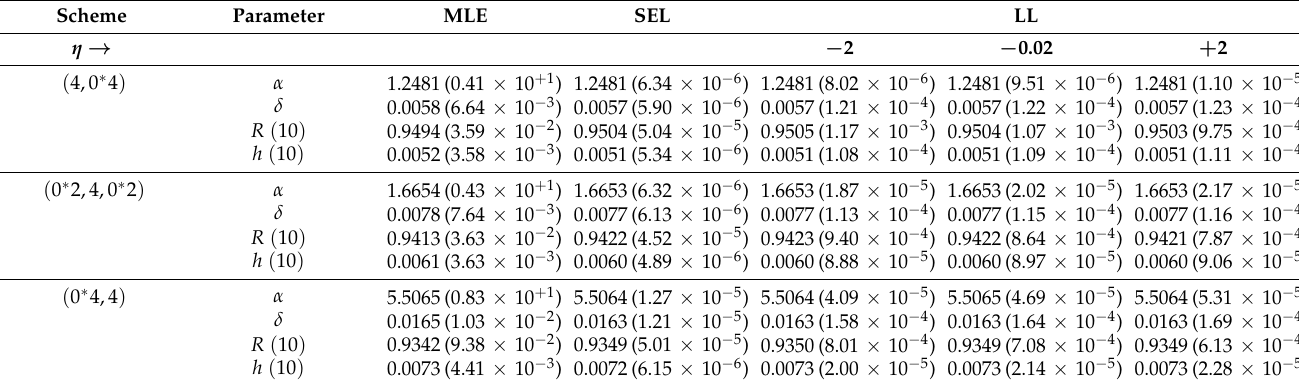
Table 12. The point estimates (SEs) of α , δ , R ( t ) , and h ( t ) using electronic devices data.